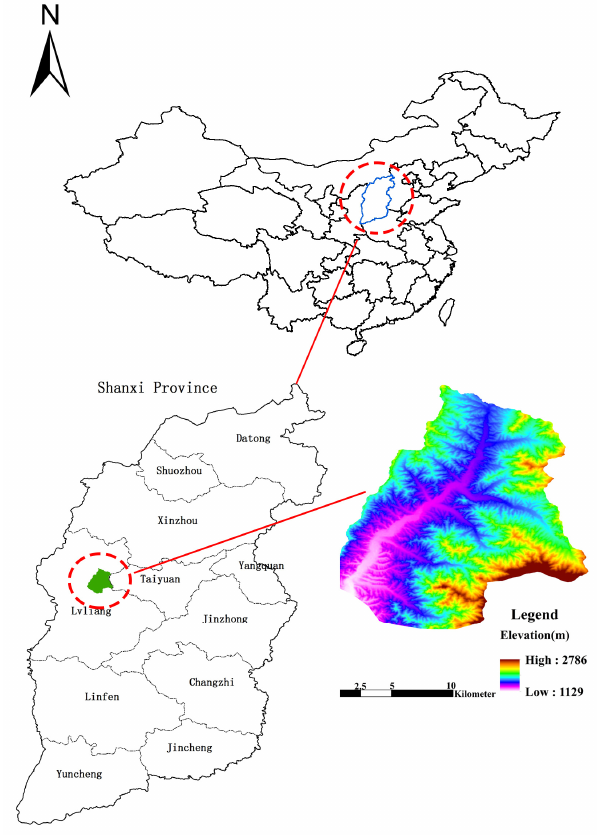
Figure 1. The location and area of Gedong basin.